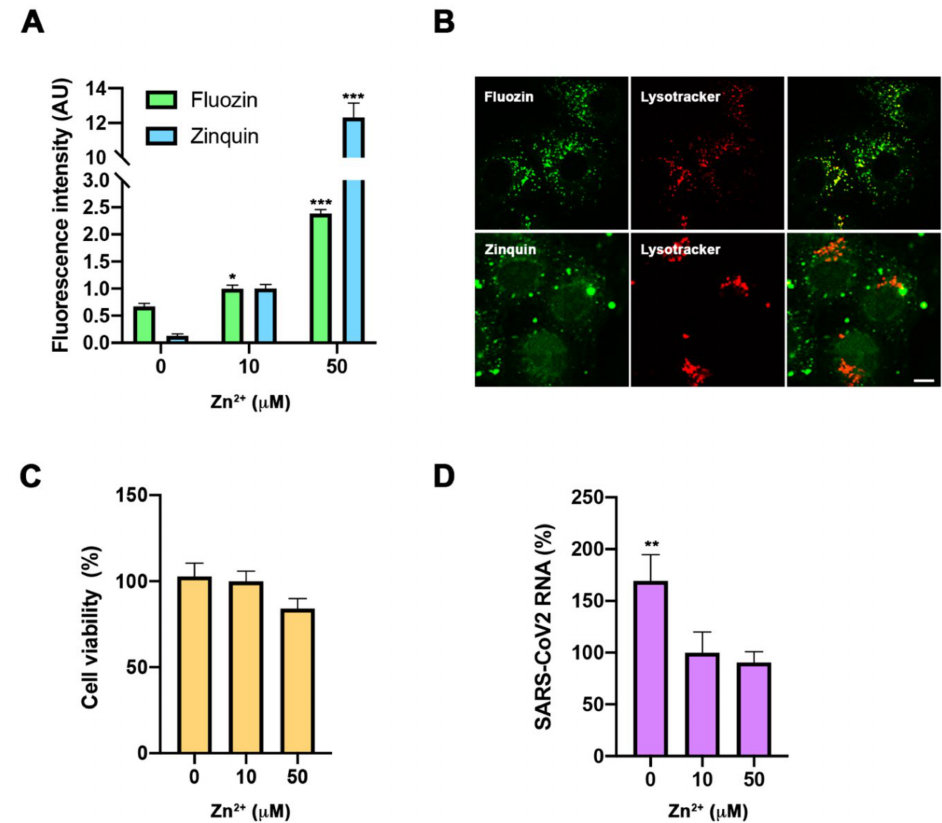
Figure 2. Evaluation of zinc homeostasis in SARS-CoV-2 infection. ( A , B ). Intracellular zinc content measurement using FluoZin-3AM and Zinquin probes in Vero E6 cells. ( A ). Flow cytometry in cells incubated for 30 min with 0, 10, and 50 µ M extracellular Zn 2+ content. Intensity expressed in arbitrary units (AU) ( n = 3; * p < 0.05, *** p < 0.001; Bonferroni-corrected one-way ANOVA compared to 0 Zn 2+ ). ( B ). Confocal images of living cells incubated with FluoZin-3AM (up) or Zinquin (bottom) and Lysotyracker in 50 µ M Zn 2+ extracellular medium. Scale bar = 10 µ m. ( C ). Viability